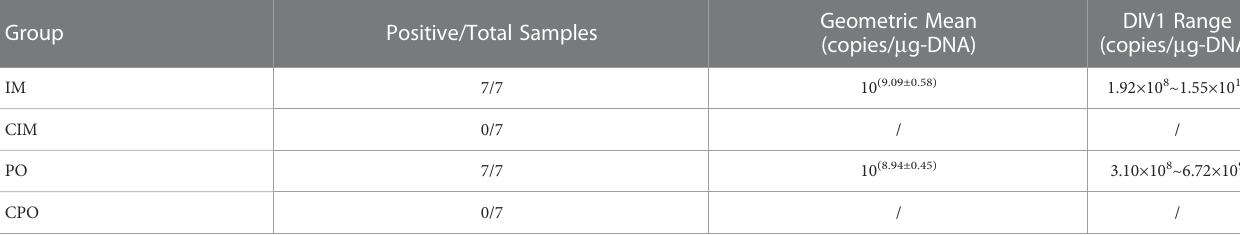
TABLE 1 DIV1 copies in different challenge and control groups of Penaeus japonicus .